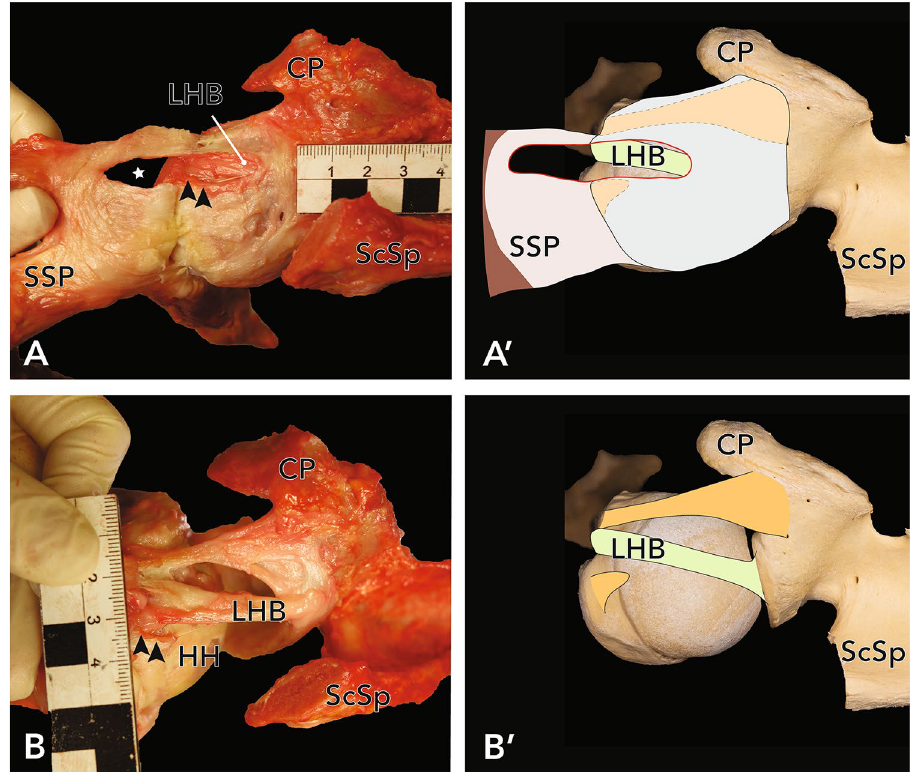
Figure 1. ( A ) Exemplary full-thickness SSP-lesion in a left shoulder, view from above. Asterix marks the full- thickness tear, the SSP is mobilized towards lateral. The LHB was visible through the tear. ( B ) After removal of the fibrous capsule and careful dissection of the CHL, a rupture of the posterolateral band was identified. Arrowheads mark the remnants of the posterolateral band ( B ) and its location before further dissection ( A ) for better orientation. ( A ′ ) and ( B ′ ) Approximation of the photographs as an overlay on humerus and scapula. HH humeral head, CP coracoid process, ScSp scapular spine, SSP supraspinatus muscle, SSC subscapularis muscle, LHB long head of biceps brachii